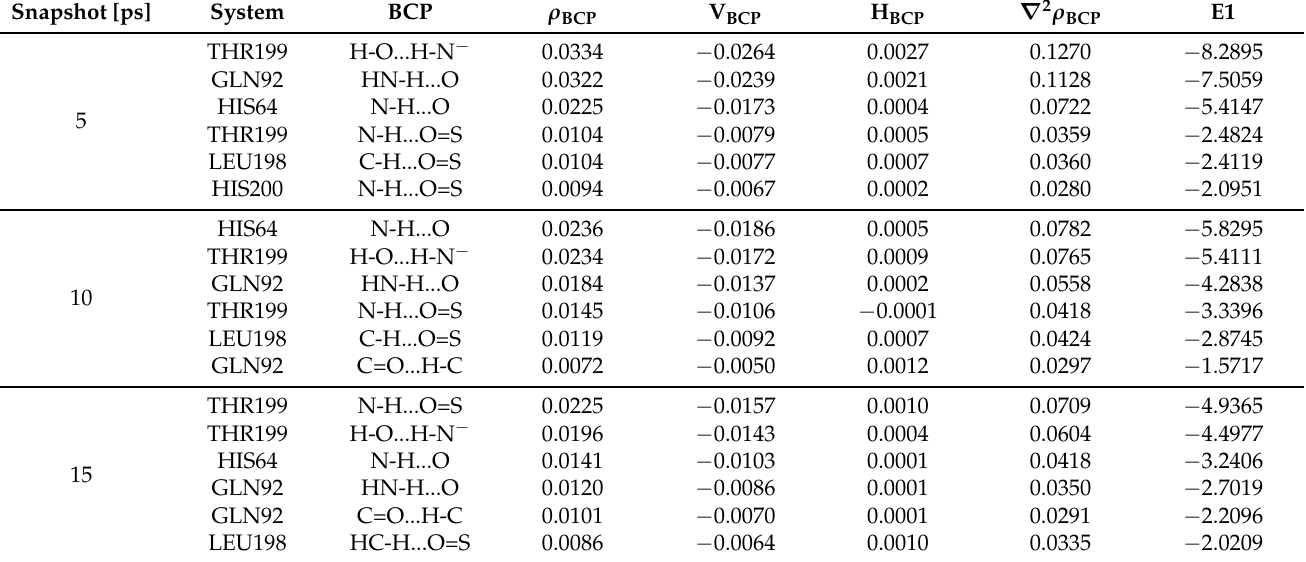
Table 1. QTAIM-derived properties at BCPs of six chosen non-covalent interactions taken from snapshots at approximately 5, 10, and 15 ps of the large model in the course of the QM/MM MD. E1 are bond energies based on Espinosa model [39]. Units of gathered quantities are as follows: electron density, ρ BCP , is provided in e · a − 3 atomic units and the Laplacian of electron density, ∇ 2 ρ BCP , is in 0 e · a − 5 units. V BCP stands for BCP potential energy density and H BCP denotes the energy density at 0 the